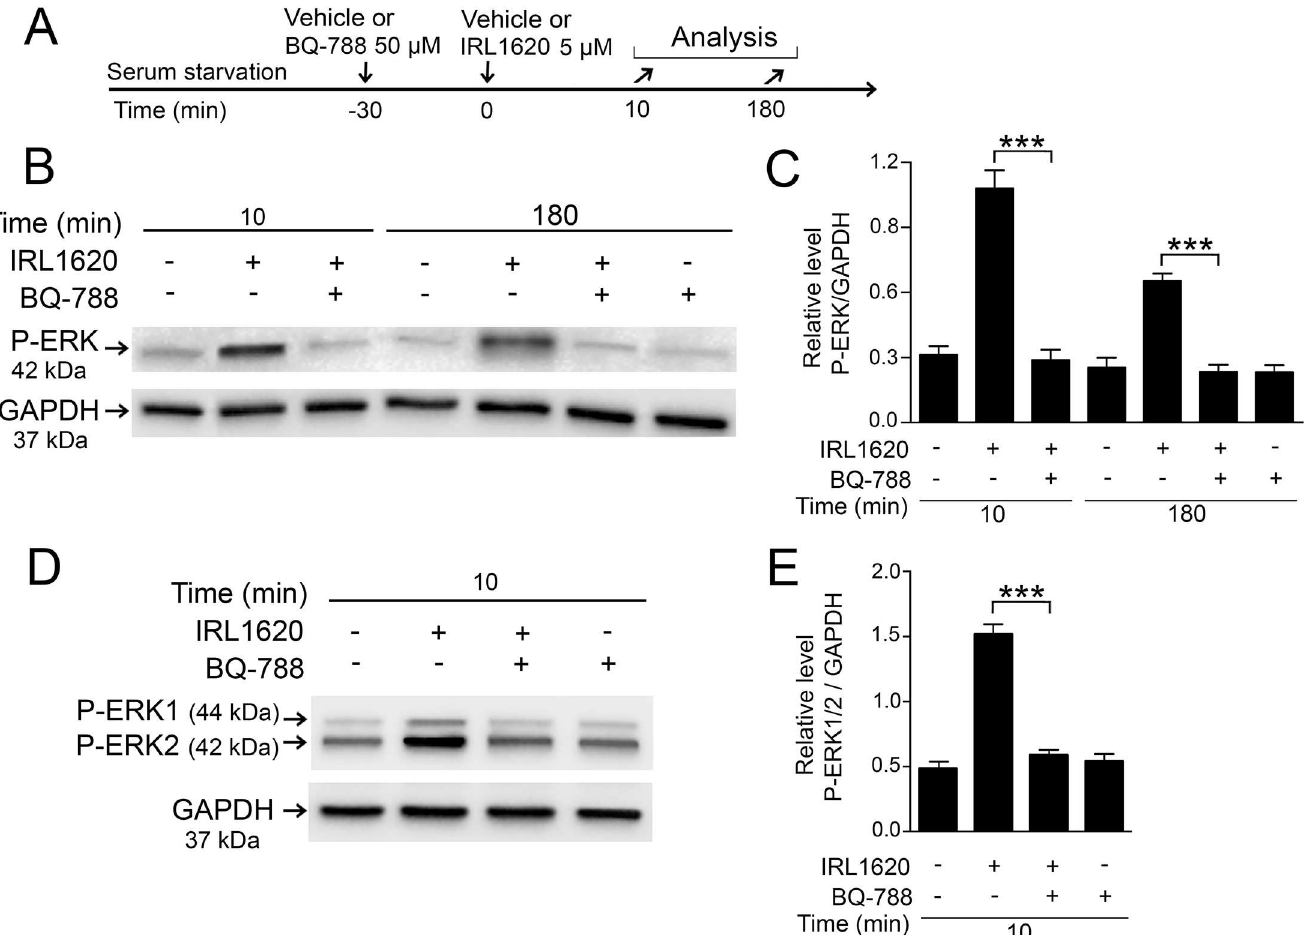
Fig 5. Effects of EDNRB blocker BQ-788 on IRL1620-induced P-ERK1/2 levels in primary chicken Mu¨ller cells and the human MIO-M1 cell line. Serum-starved primary chicken Mu¨ller cells and human MIO-M1 cells were pretreatedwith 50 μ M EDNRB blockerBQ-788 or vehicle(control) for 30 min followedby 5 μ M IRL1620or vehicle for 10 and 180 min. (A) Experimental outline. (B, D) Representative western blot gels showingP-ERK levels in (B) primary chick Mu¨ller cells and (D) the humanMIO-M1 cell line. (C, E) Bar graphs with densitometry of P-ERK levels normalized to GAPDH levels. Bar graphsare mean ± SEM, n = 3 ( *** P < 0.0001) analyzedby one-wayANOVA and Tukey’s post hoc test. Significance is indicatedfor the comparisons IRL162010 min-IRL1620+BQ-788 10 min and IRL1620180 min-IRL1620+BQ-788 180